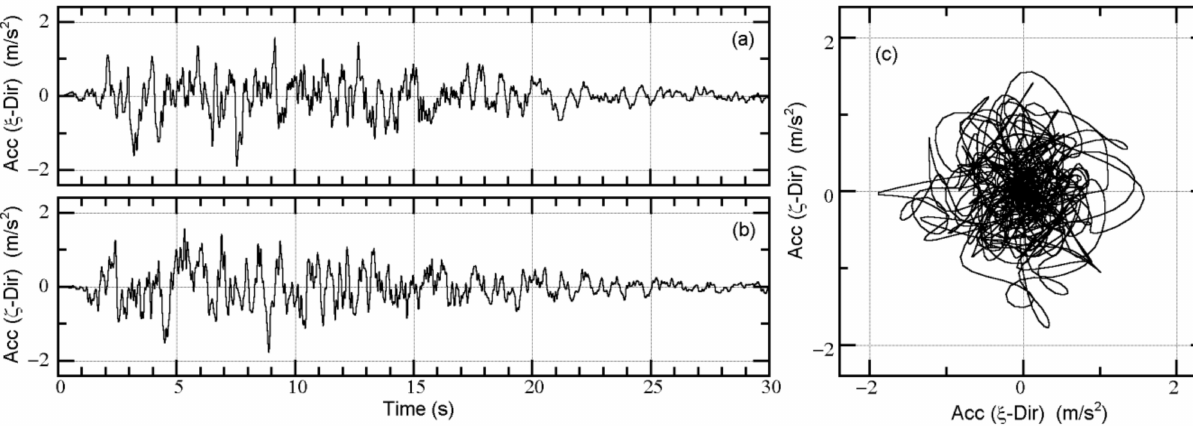
Figure 14. Two components of the generated artificial ground motion (Art-2-00): ( a ) ξ direction; ( b ) ζ direction; ( c )